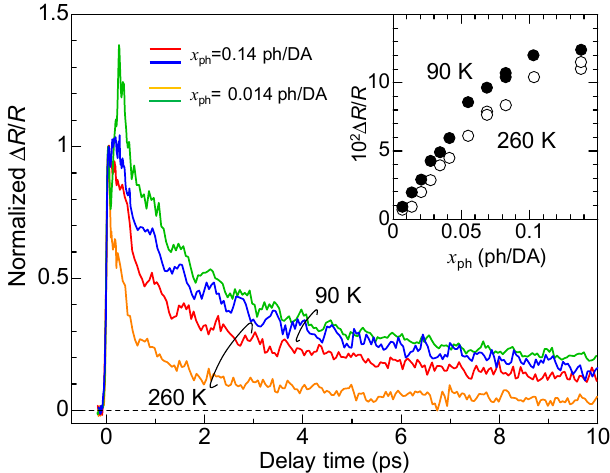
Figure 17. Normalized time evolutions of Δ R / R signals at different temperatures and excitation densities in the ionic phase of TTF-CA [33]. Spectra of pump and probe pulses are shown in Figure 13a. The green line: 90 K and 0.014 ph/ DA . The blue line: 90 K and 0.14 ph/ DA . The orange line: 260 K and 0.014 ph/ DA . The red line: 260 K and 0.14 ph/ DA . The inset shows excitation photon density ( x ph ) dependence of Δ R / R at 90 K (solid circles) and 260 K (open circles).